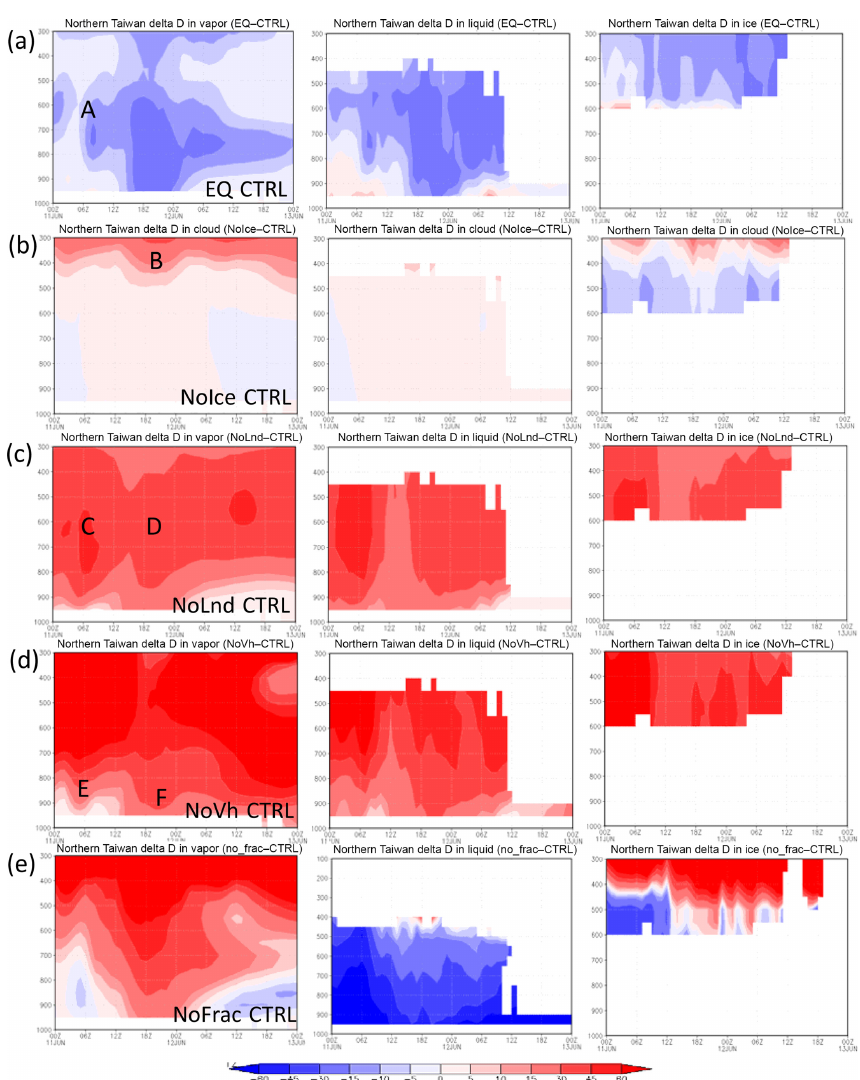
Figure 10. Time evolution of the vertical distribution of water vapor δ D (left), liquid-phase water (cloud water and rainwater; middle), and ice-phase water (including cloud ice, snow and graupel; right) over Northern Taiwan (121.123 ◦ E, 25.27 ◦ N) in different simulations: (a) EQ CTRL, (b) Nolce CTRL, (c) NoLnd CTRL, (d) NoVh CTRL, and (e) NoFrac CTRL on 11–12 June 2012. The ordinate is pressure (hPa), and abscissa is